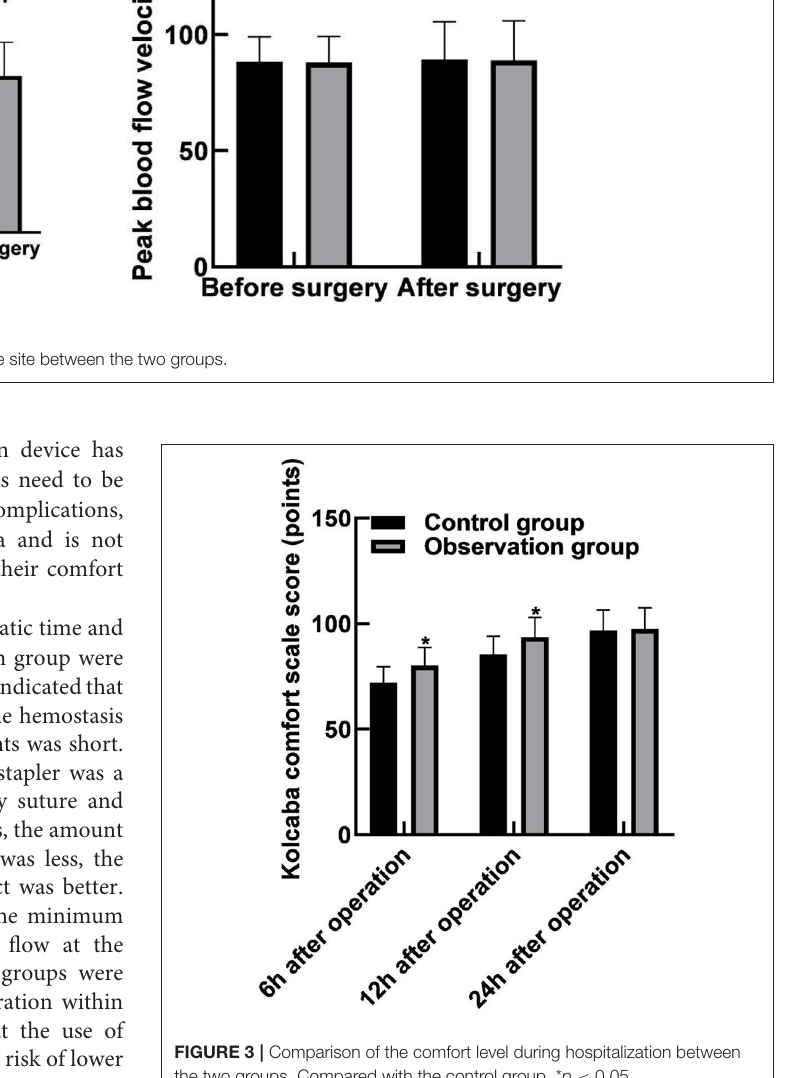
arterial ischemia, vasovagal reflex, and others, seriously affecting the patient’s motor ability, and the patient’s comfort level was poor. The vascular suture device directly sutures the punctured blood vessels through suture lines, which are simple to operate and rapid to stop bleeding and can significantly reduce the compression on the artery. Moreover, the patient’s limb braking time is short, and the patient’s motor ability is not affected, so, the patient’s comfort level is high (23, 24). However, 24 h after the surgery, there was no significant difference in the scores between the two groups based on Kolcaba Comfort Scale. It indicated that the comfort levels of the patients between the